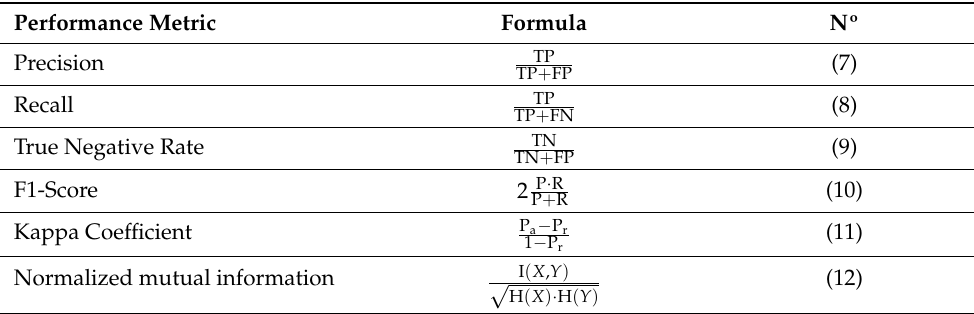
Table 2. Principal performance metrics used to evaluate the